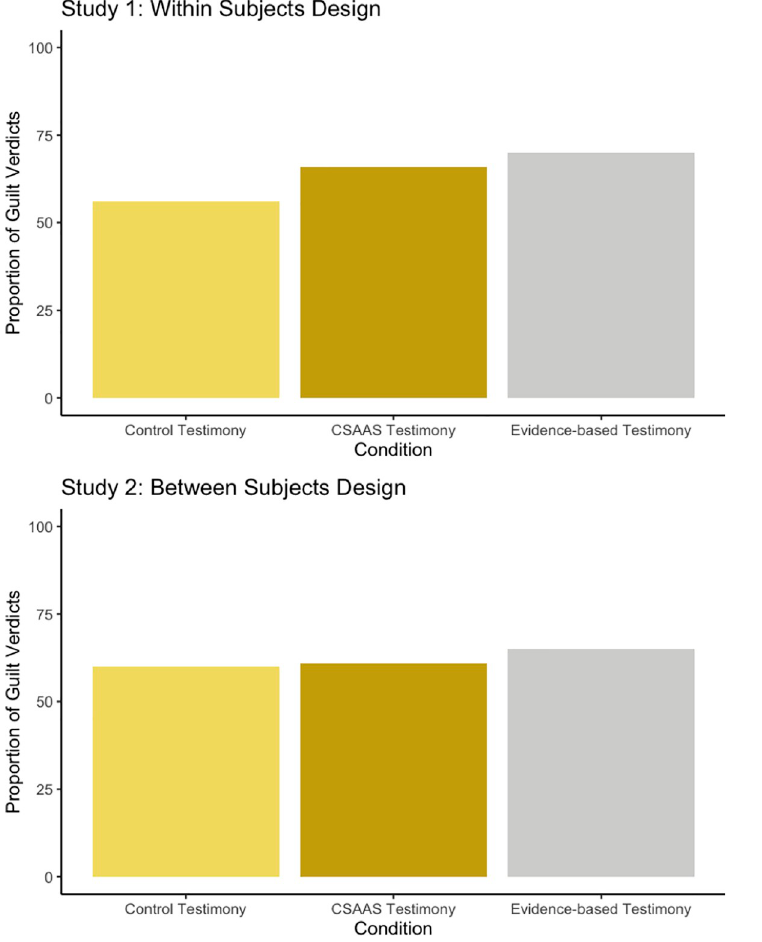
Fig 2. Study 1 and Study 2 proportion of guilt verdicts by